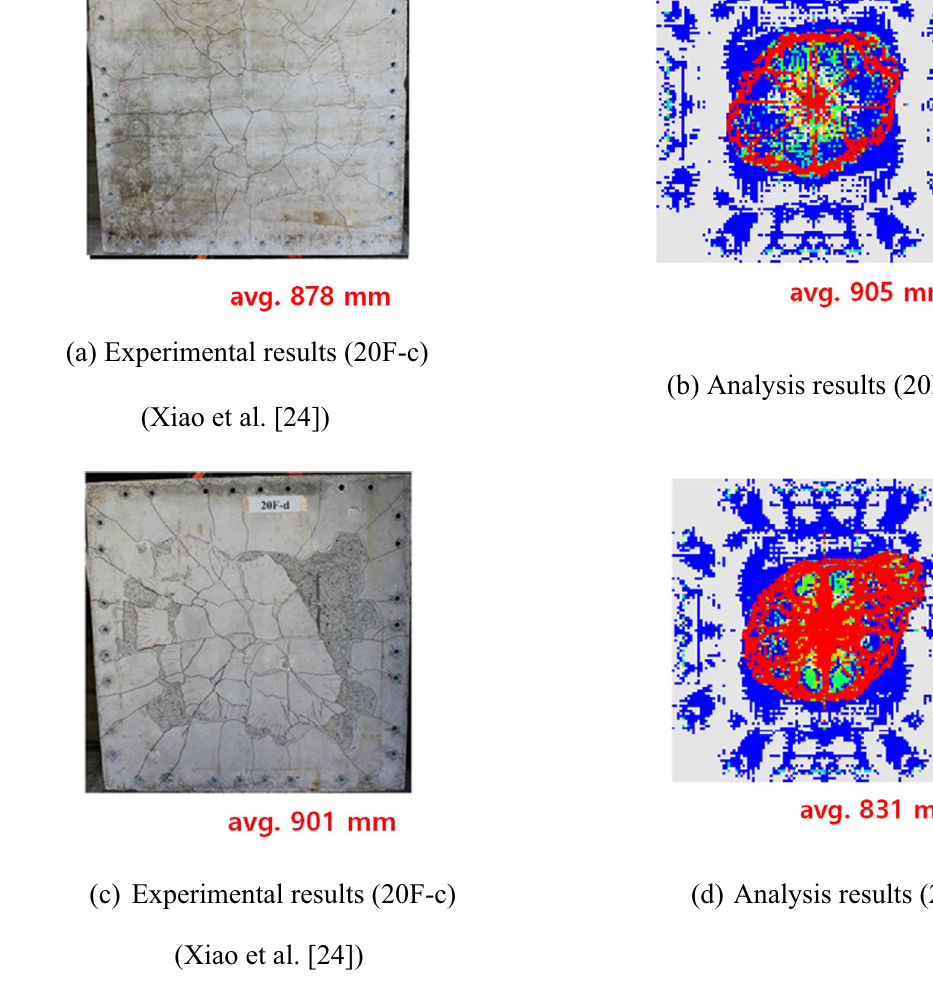
Figure 4. Verification of the SPH numerical model.